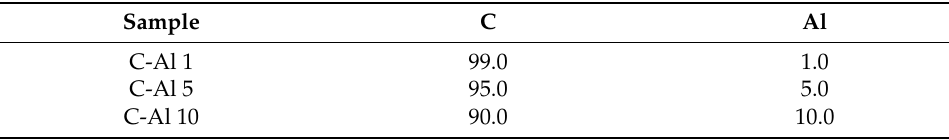
Table 2. Samples with casein/aluminum oxide particles, ( w / w